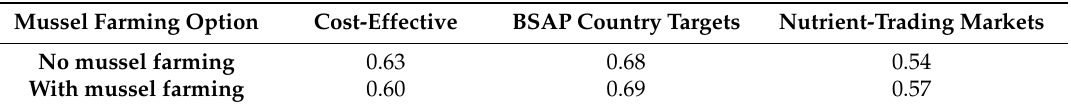
Table 2. Calculated Gini coefficients under different combinations of inclusion of mussel farming and international nutrient policy regimes.